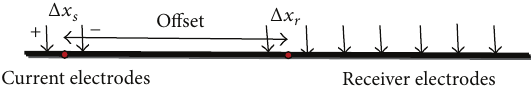
Figure 4: 3D slice of electromagnetic field diffusion over homogeneous half-space at different time delays. (a) to (d) show the electric field at 5.5 ms, 8.2 ms, 11ms, and 13.7 ms, respectively. The positions of 𝑥 -slice, 𝑦 -slice, and 𝑧 -slice used were 500 m, 30 m, and 30m, respectively.